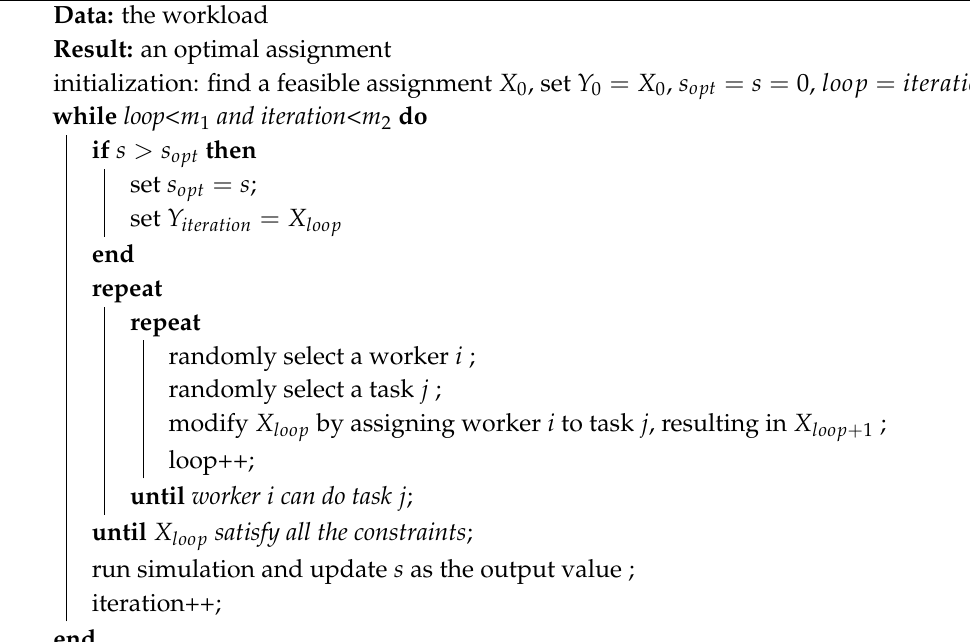
Algorithm 1: The random neighborhood search